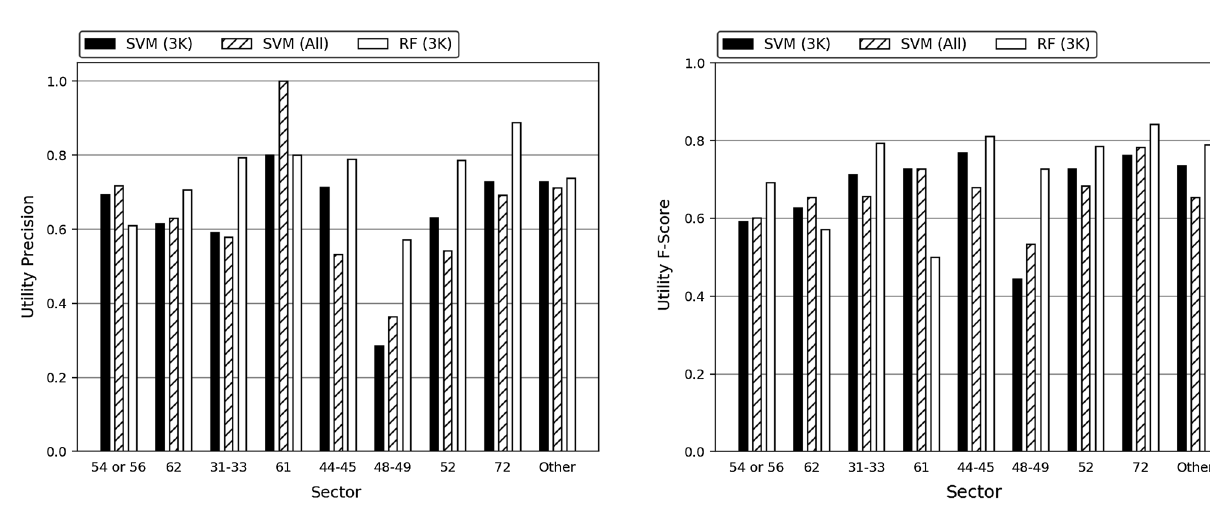
Fig. 2 Utility precision for identifying errors per industry